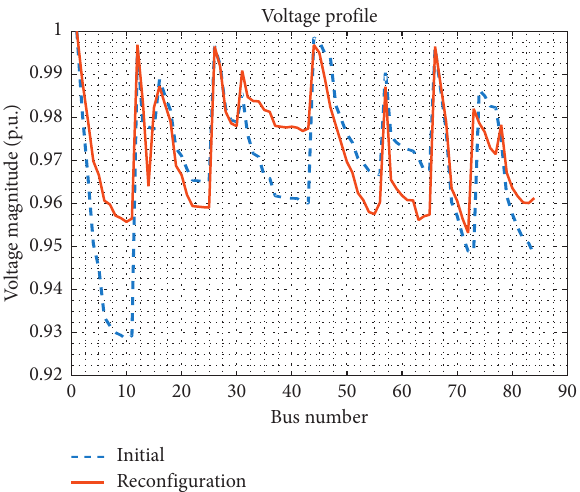
Figure 8: The voltage profile for the 84-bus system before and after